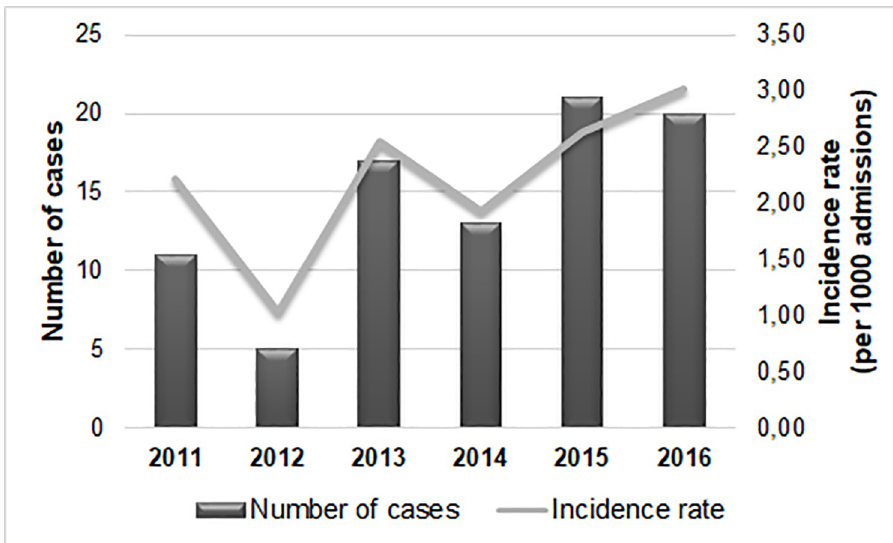
Fig 1. Number of cases and incidence rate of candidemia observed during a 6-year period in a tertiary hospital in Northeast Brazil.